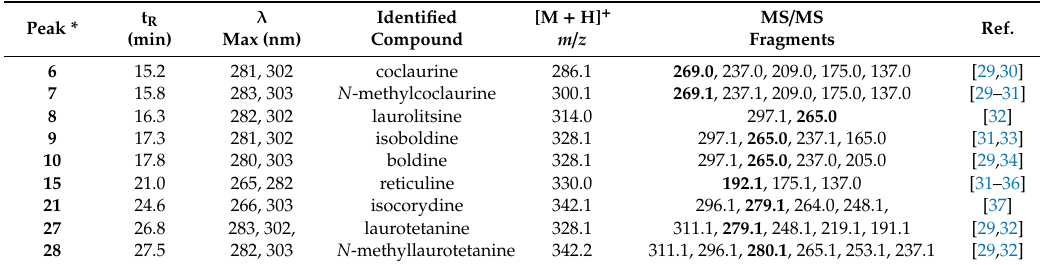
* Peak numbers are the same as the ones depicted in Figure 2. Bold values represent the base peak of the mass